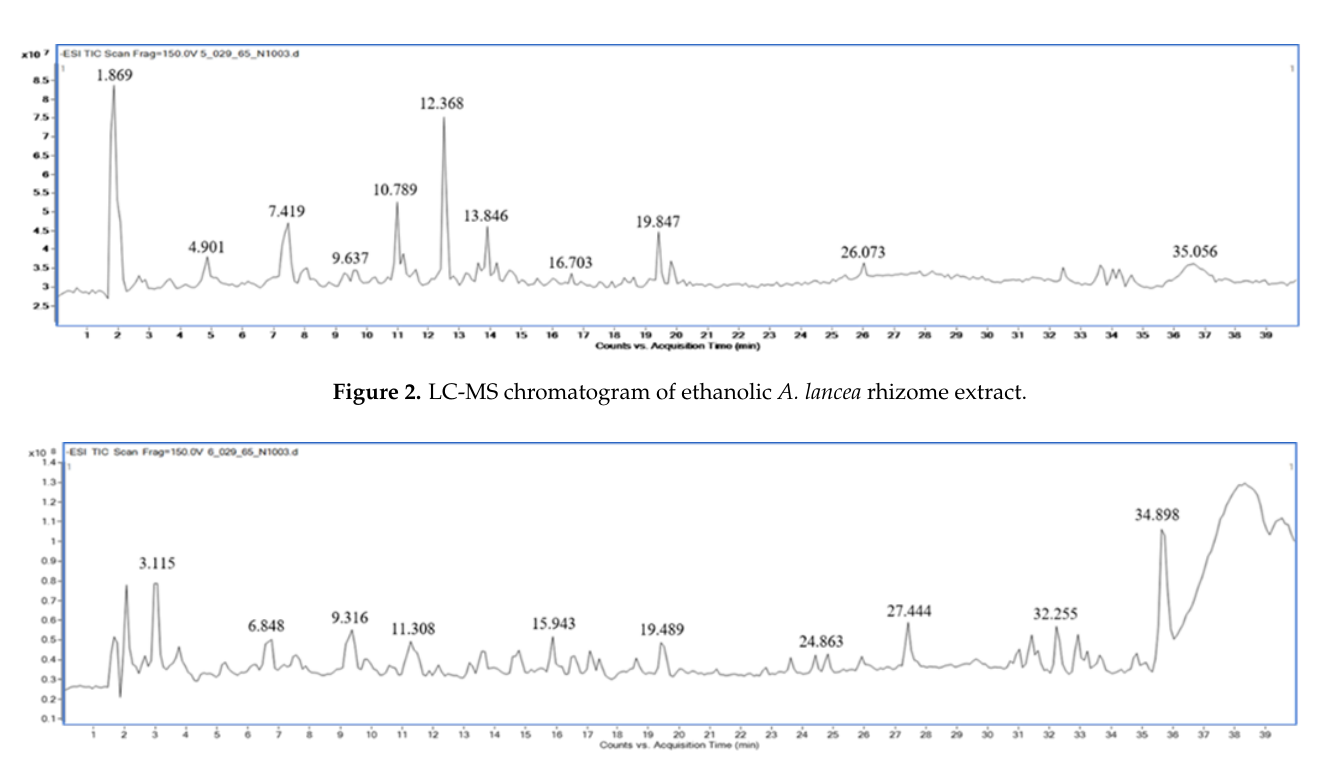
Figure 1. LC-MS chromatogram of ethanolic M. fragrans mace extract.